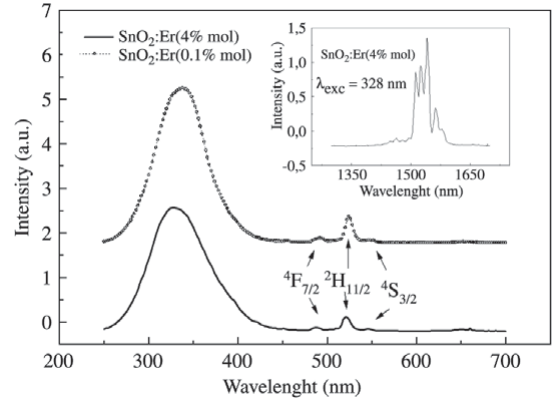
Figure 1. Excitation spectra for SnO xerogels, emission fixed at 1530 nm. Inset-Emission spectra for SnO +4%Er xerogel, excitation fixed at 328 2